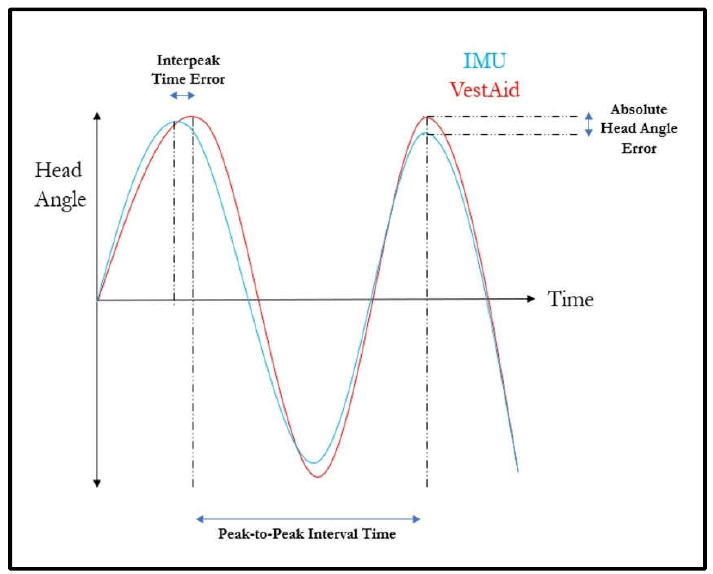
Figure 15. Temporal and spatial error metrics used to compare the VestAid and IMU-based system.